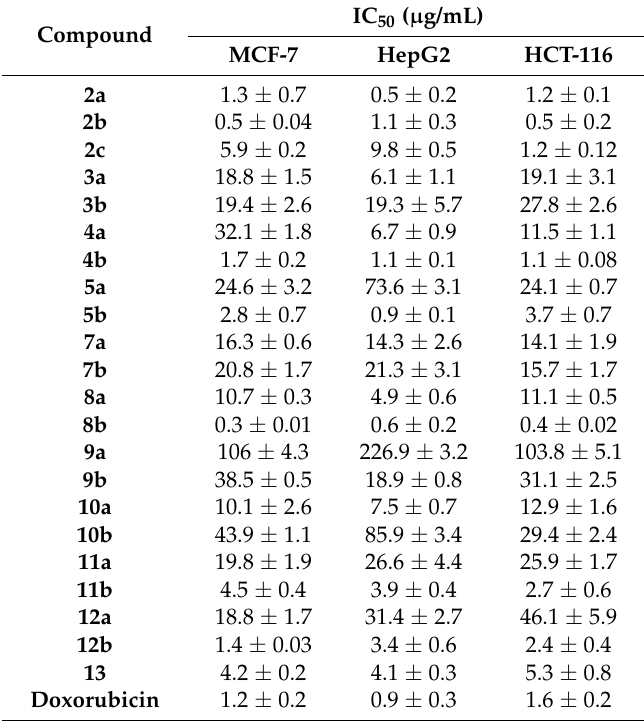
Table 4. The IC 50 ( µ g) of the new tested chemicals compounds against different tumor cell lines.